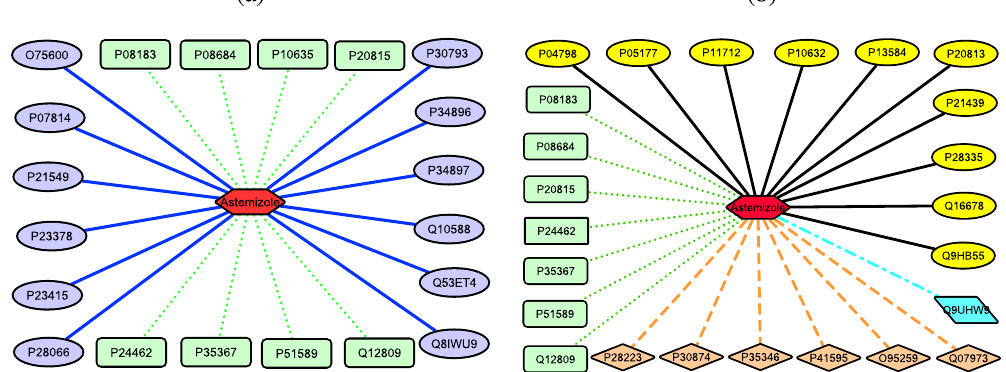
Figure 8. New drug repositioning candidates of astemizole. Figure ( a ) describes the known DTIs and extracted NDTISs of astemizole. Red hexagon denotes astemizole, the green dotted lines denote known DTIs, the blue solid lines denote extracted NDTISs in ( a ). Figure ( b ) describes predicted DTIs of astemizole. The green dotted lines denote successfully predicted DTIs, the orange dash lines denote predicted DTIs that can be validated by the related databases, the azure dash dotted line denotes predicted DTIs which have been reported by ref. 26, the black solid lines denote the other predicted results in ( b ).